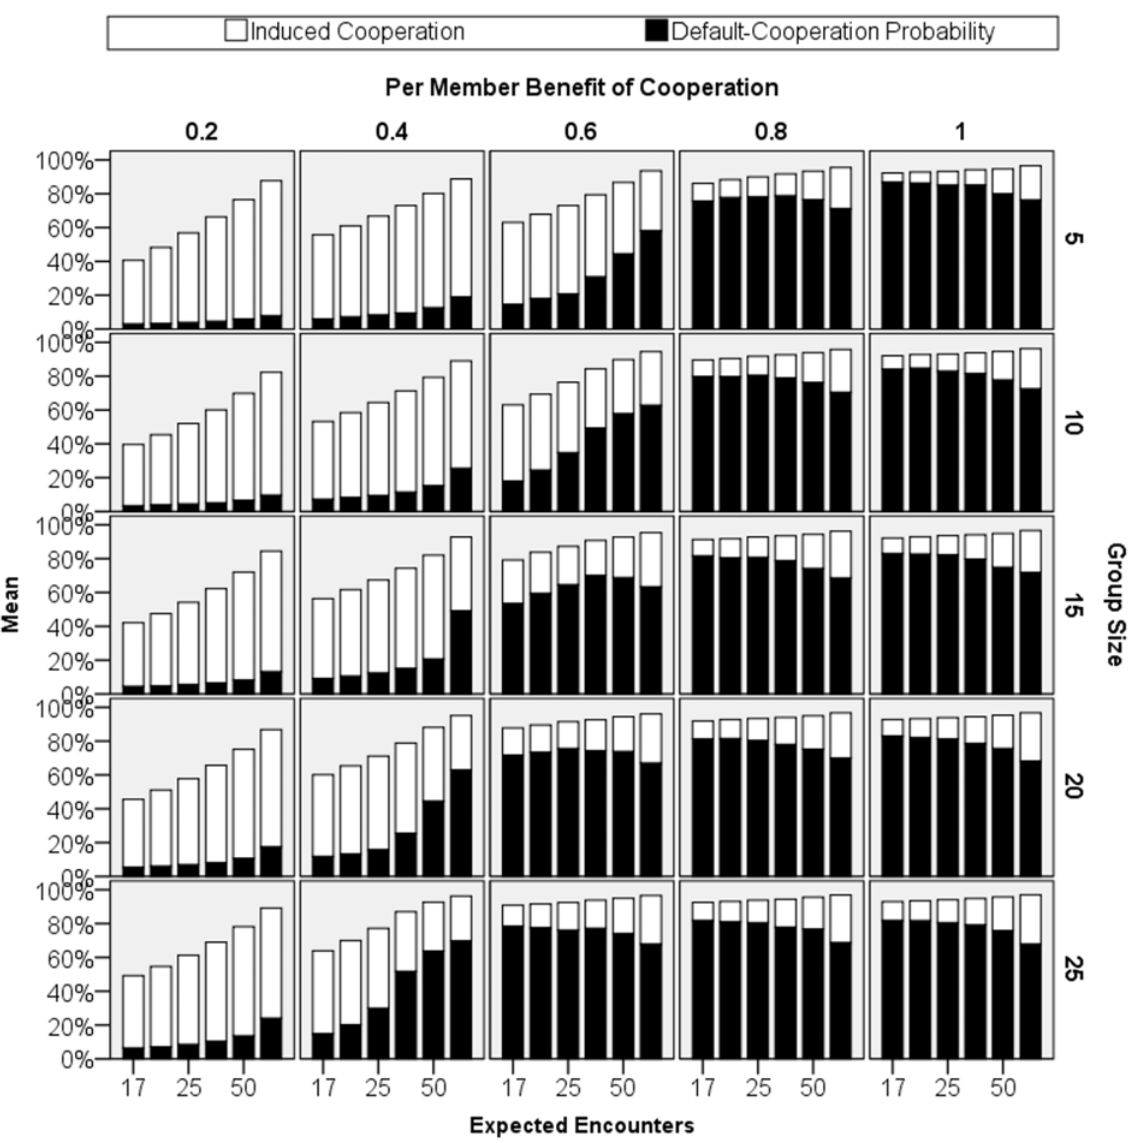
Fig 3. Final averaged cooperation rate (genetic & induced). This figure plots the average cooperation rate of the final round of the last 500 generations of each simulation. The full height of each bar indicates the cooperation rate. The cooperation rate is decomposed into cooperation induced by punishment (white) and cooperation given by the gene Default-Cooperation Probability